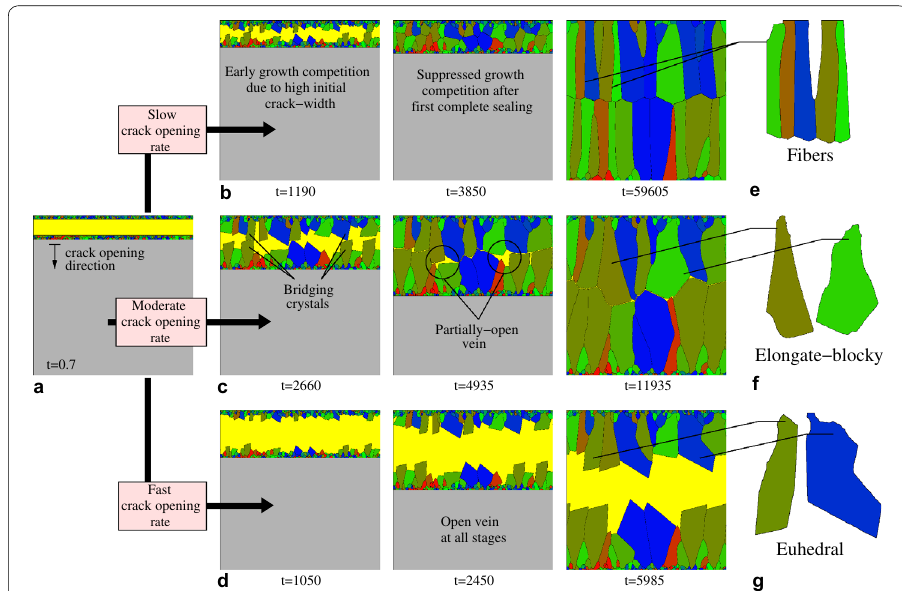
Fig. 4 a Computational domain with an initial crack width of 100 (cid:31) x . Simulated bitaxial crystal growth for different values of crack opening rates: b Slow crack opening rate � x / 1000 � t , c moderate crack opening rate � x / 200 � t , and d fast crack opening rate � x / 100 � t . The progression is shown at representative simulation time steps. The selected crystals in the resulting vein morphologies are illustrated. e Fibers with almost equal width. f Elongate-blocky crystals with increasing width. g Crystals forming euhedral flat facets due to availability of sufficient pore space for crystal